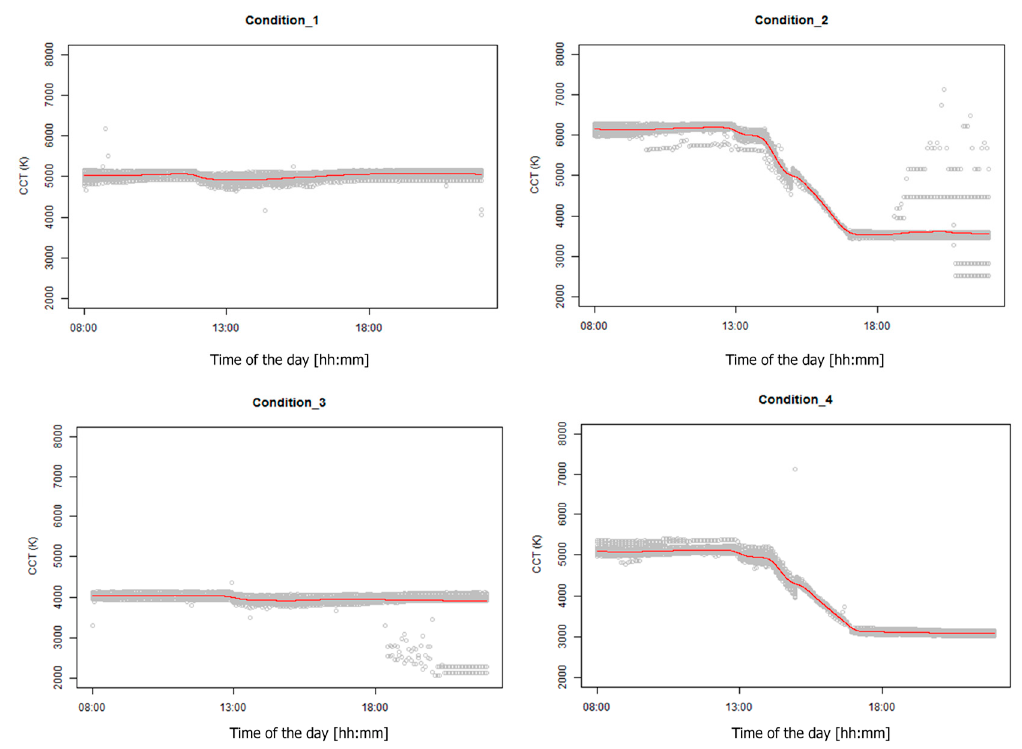
Figure 9. Daily temporal CCT variations in all lighting conditions (Condition_1: JP-T; Condition_2: JP-D; Condition_3: US-T; Condition_4: US-D).